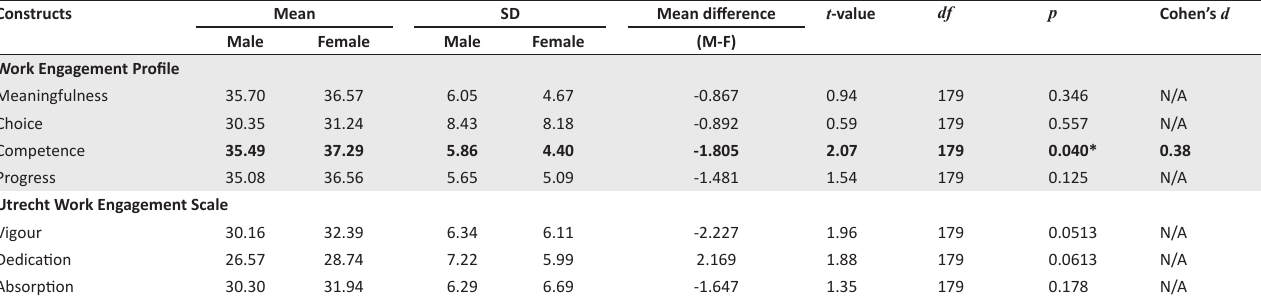
TABLE 9: Results of the t -test for gender differences.